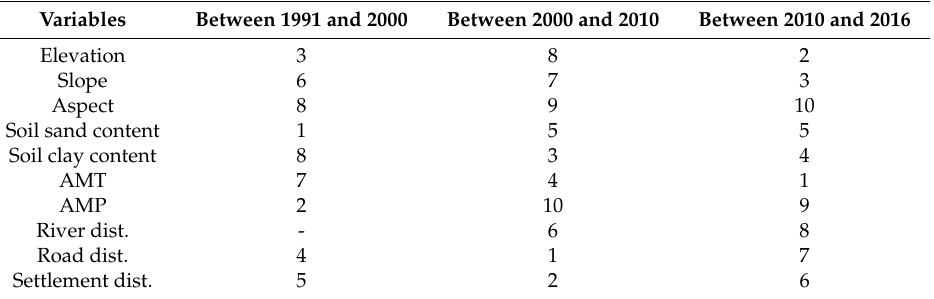
Table 9. Drivers of farmland expansion in our three LR models ranked in order of importance. Variables Between 1991 and 2000 Between 2000 and 2010 Between 2010 and 2016 Elevation 3 8 2 Slope 6 7 3 Aspect 8 9 10 Soil sand content 1 5 5 Soil clay content 8 3 4 AMT AMP 2 River dist.